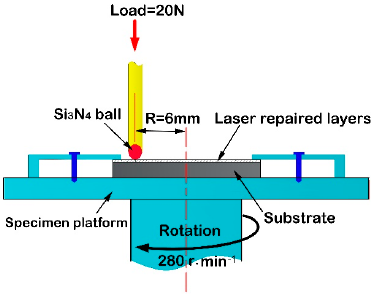
Figure 2. Schematic of wear test.